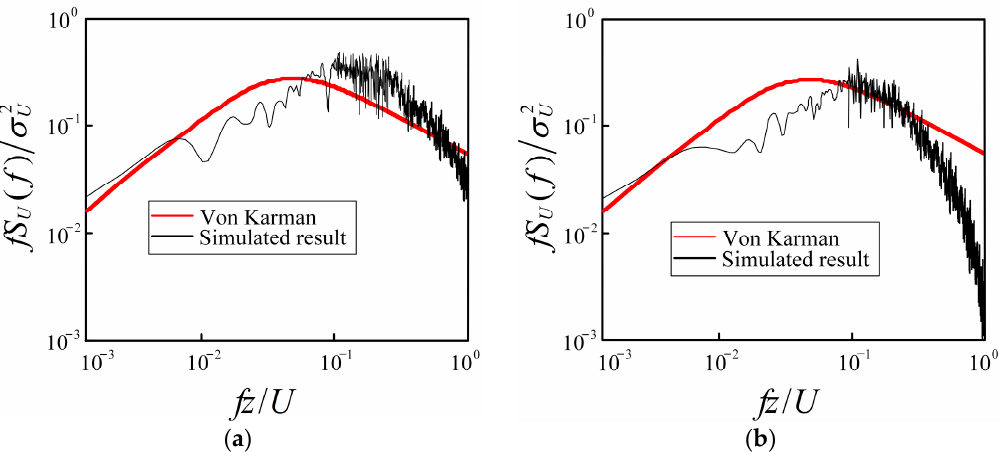
Figure 5. Wind velocity power spectra under different grid division schemes: ( a ) Scheme 1, fine grids; ( b ) Scheme 2, coarse grids.